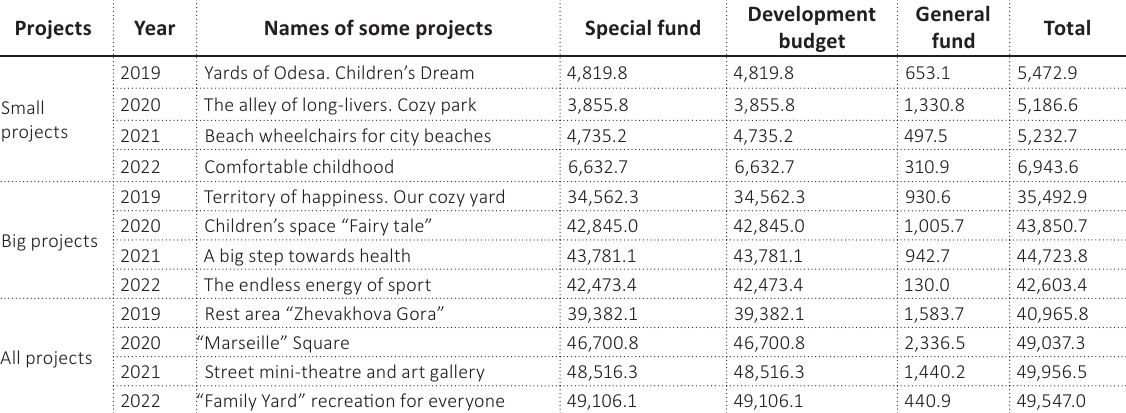
Table A5. Expenditures for the implementation of the public budget projects of the city of Odesa, thousand UAH, during